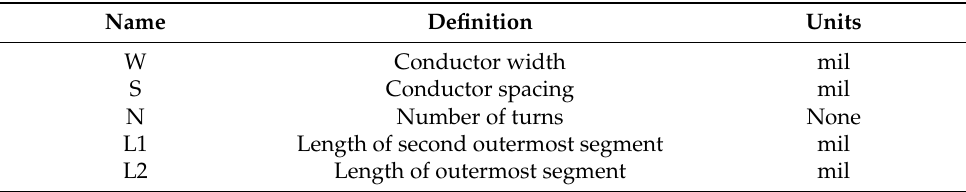
Figure 3. Geometrical layout of the planar spiral inductor. Table 1. Parameter of microstrip rectangular inductor.